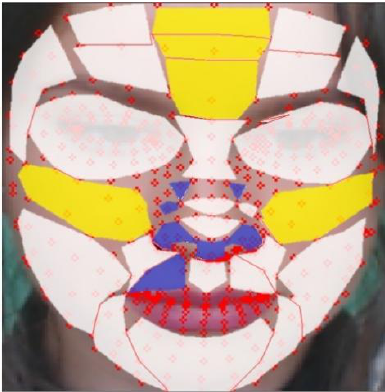
Figure 10 is a visualization of the results of Table 5. The yellow areas are the TOP-5 regions, and the blue areas are the BOT-5regions. The white regions are the other remaining 21 regions.